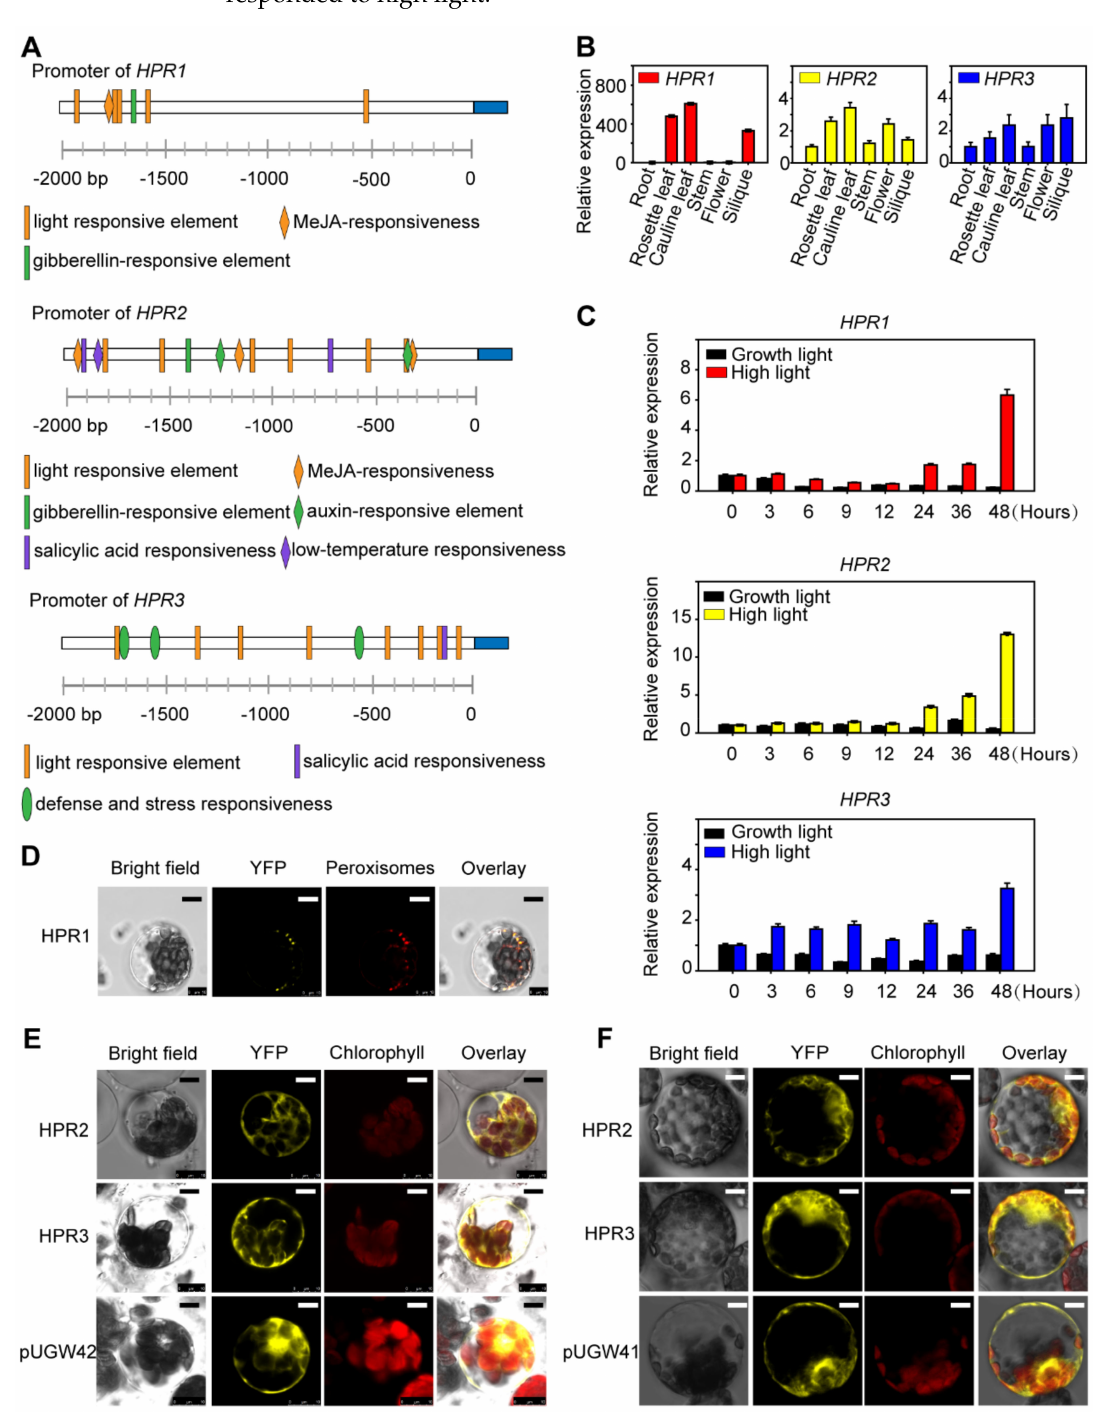
Figure 1. The expression pattern analysis of HPR1 , HPR2 and HPR3 . ( A ) Cis -acting regulatory elements analysis. The 2-kb DNA fragments at upstream of the ATG starting code of the HPR1 , HPR2 and HPR3 genes were analyzed using PlantCARE. (PlantCARE address: http://bioinformatics.psb. ugent.be/webtools/plantcare/html/, accessed on 17 December 2021). ( B ) Expression patterns of HPR1 , HPR2 and HPR3 in various organs of four-week-old Arabidopsis analyzed via quantitative RT-PCR. Data shown are means ± SD, n = 3, with three independent replicates. ACTIN was used as